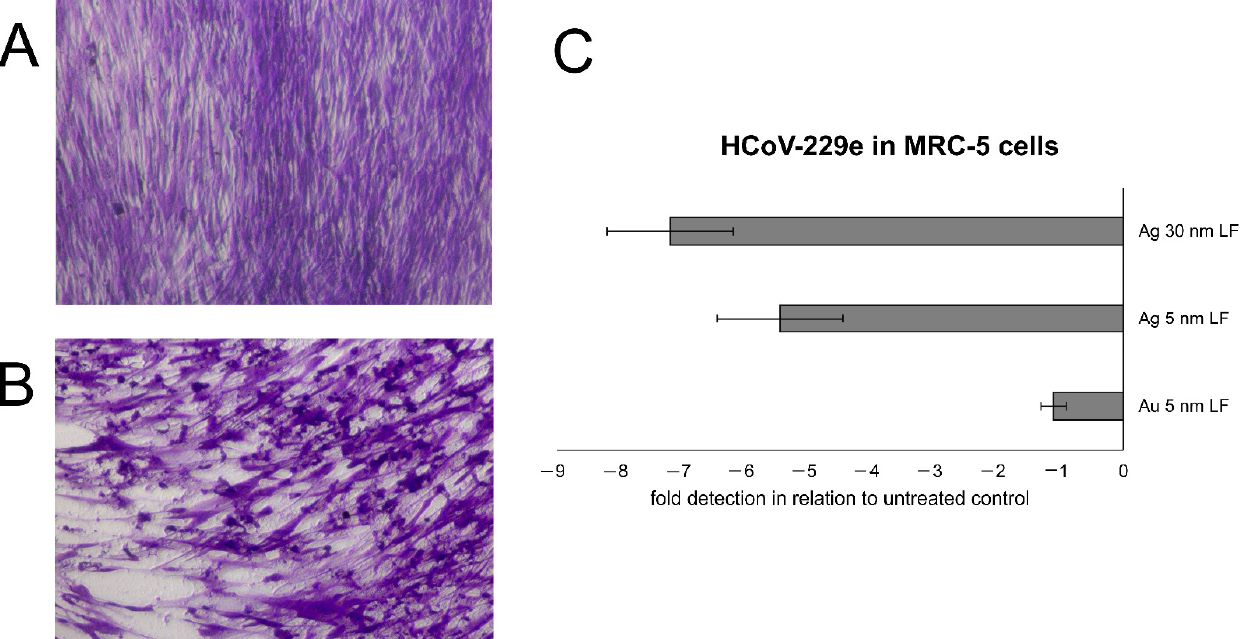
Figure 2. Human epithelial MRC-5 cells ( A ) uninfected and ( B ) infected with HCoV-229e at 48 h post infection. ( C ) HCoV-229e titers in MRC-5 cells at 48 h, treated with 7.5 μ g/mL of lactoferrin modified 5 nm AuNPs, 5 nm AgNPs or 30 nm AgNPs. Data represent means ± SEM (Own unpublished